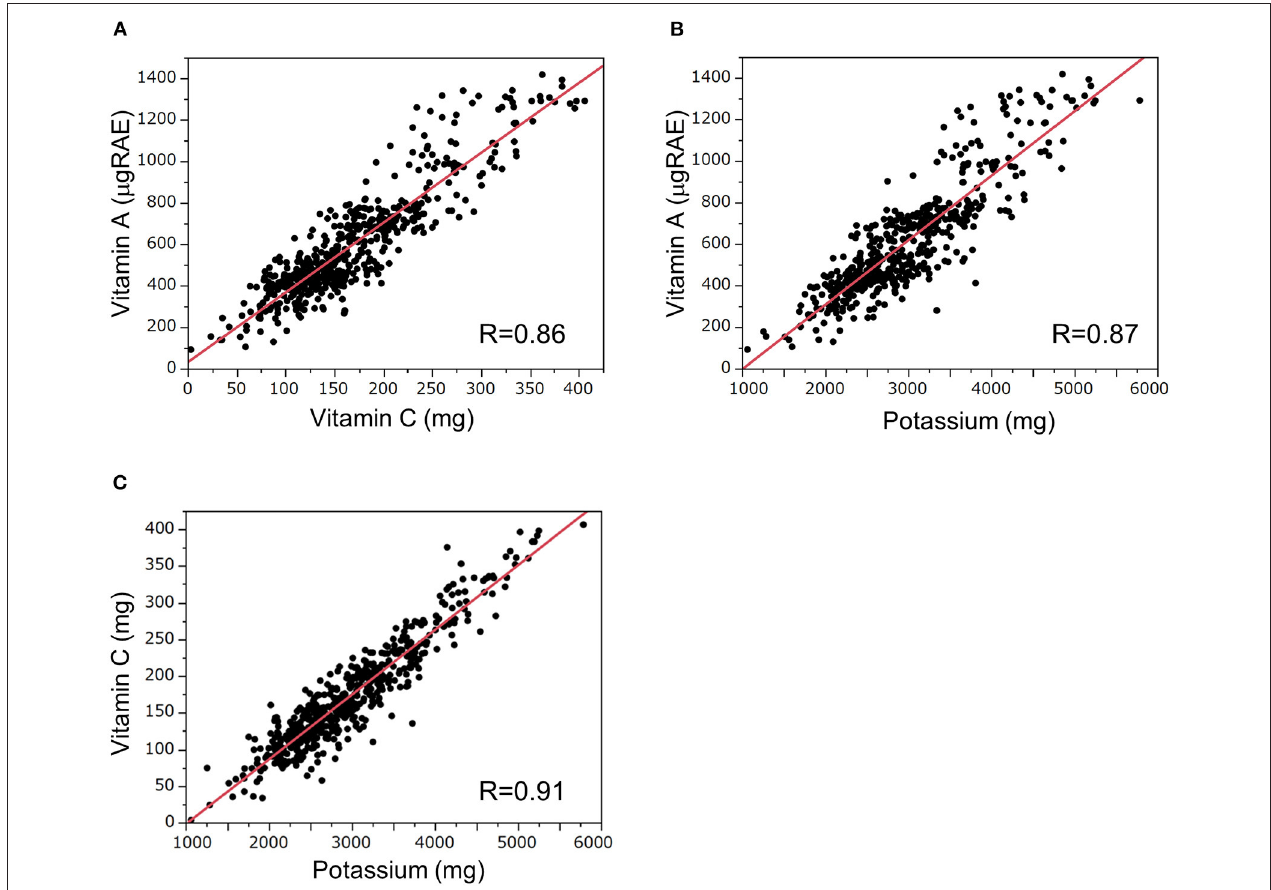
FIGURE 2 | Correlations of dietary daily intakes of vitamins A, C, and potassium. Correlations between dietary intake of (A) vitamin A and vitamin C, (B) vitamin A and potassium, and (C) vitamin C and potassium. The correlations were analyzed by Spearman’s rank correlation test. RAE, retinol activity equivalent.